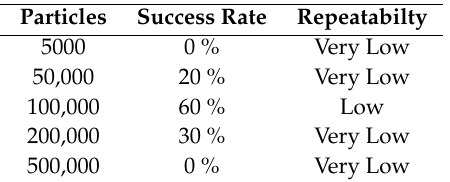
Table 2. Filter performance with random initialization.